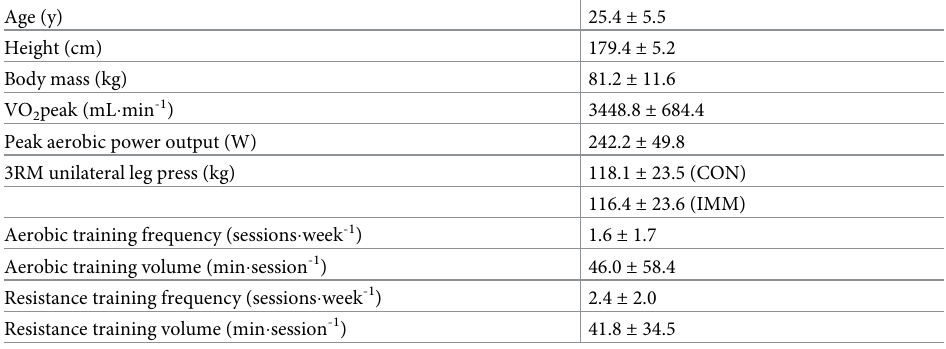
Table 1. Participant characteristics at baseline (mean ± SD) prior to commencing the